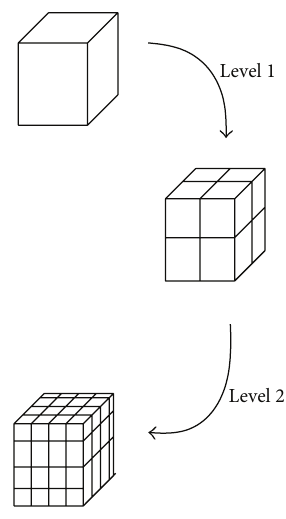
Figure 1: Recursive subdivision of the initial